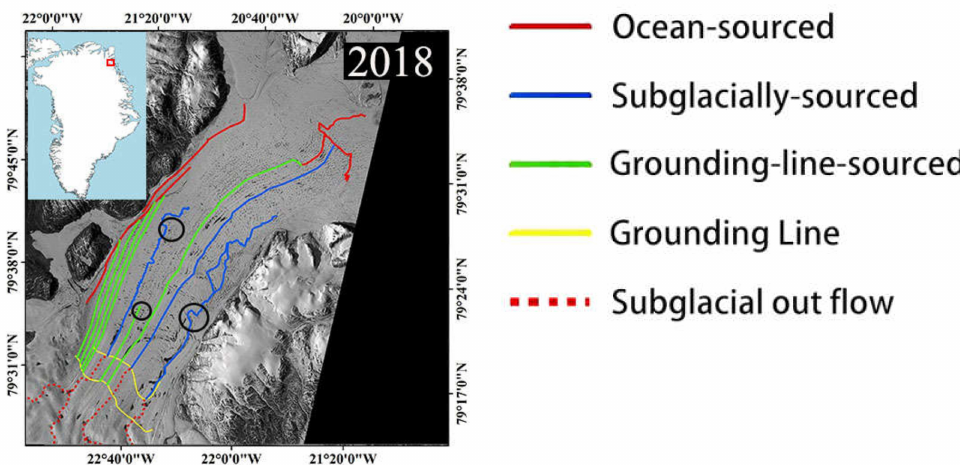
Figure A5. The distribution of 79NG ice shelf basal channels from 2000 to 2018. The positions marked by black circles in some images represent the areas with large changes in the basal